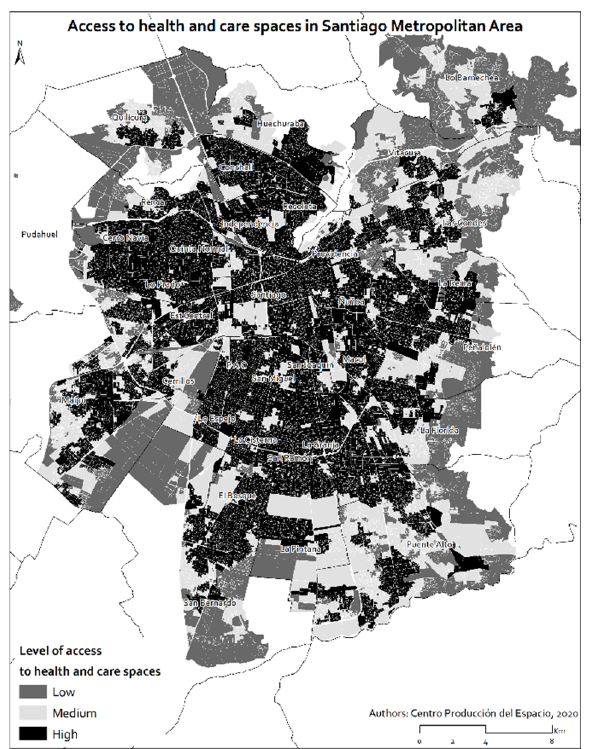
Figure 5. Access to Health and Care in the Santiago Metropolitan Area. Source: authors.